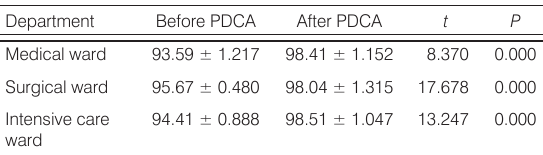
Table 4. The drug dispensing satisfaction in patients before and after the PDCA cycle